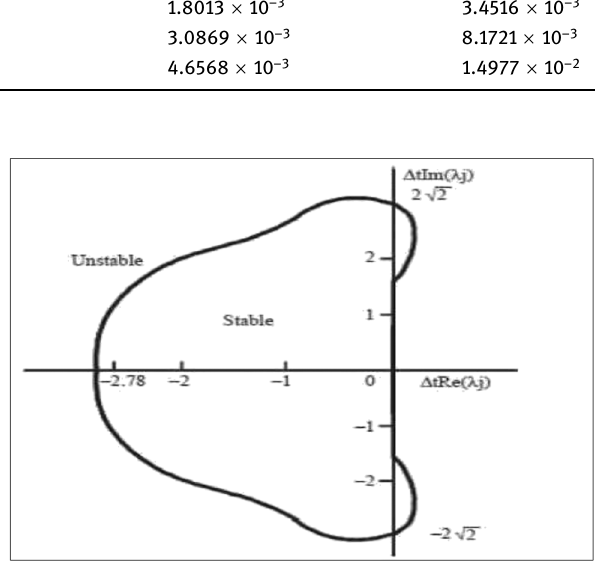
Figure 14: Stability